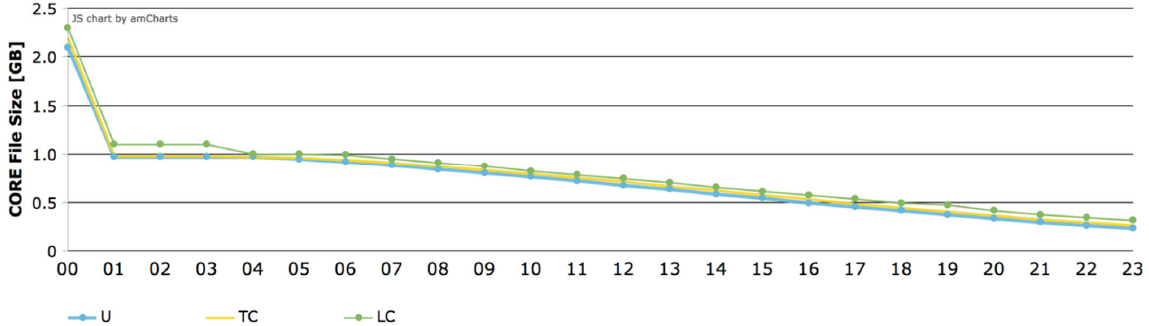
Figure 5. Decreasing CORE file sizes (in GB) with increasing CRF (from 0 to 23); CORE file sizes are listed in Table A1 from Appendix A, with the figure data available also online as an interactive editable chart at: https://live.amcharts.com/jA4NW/, accessed on 17 August 2021.